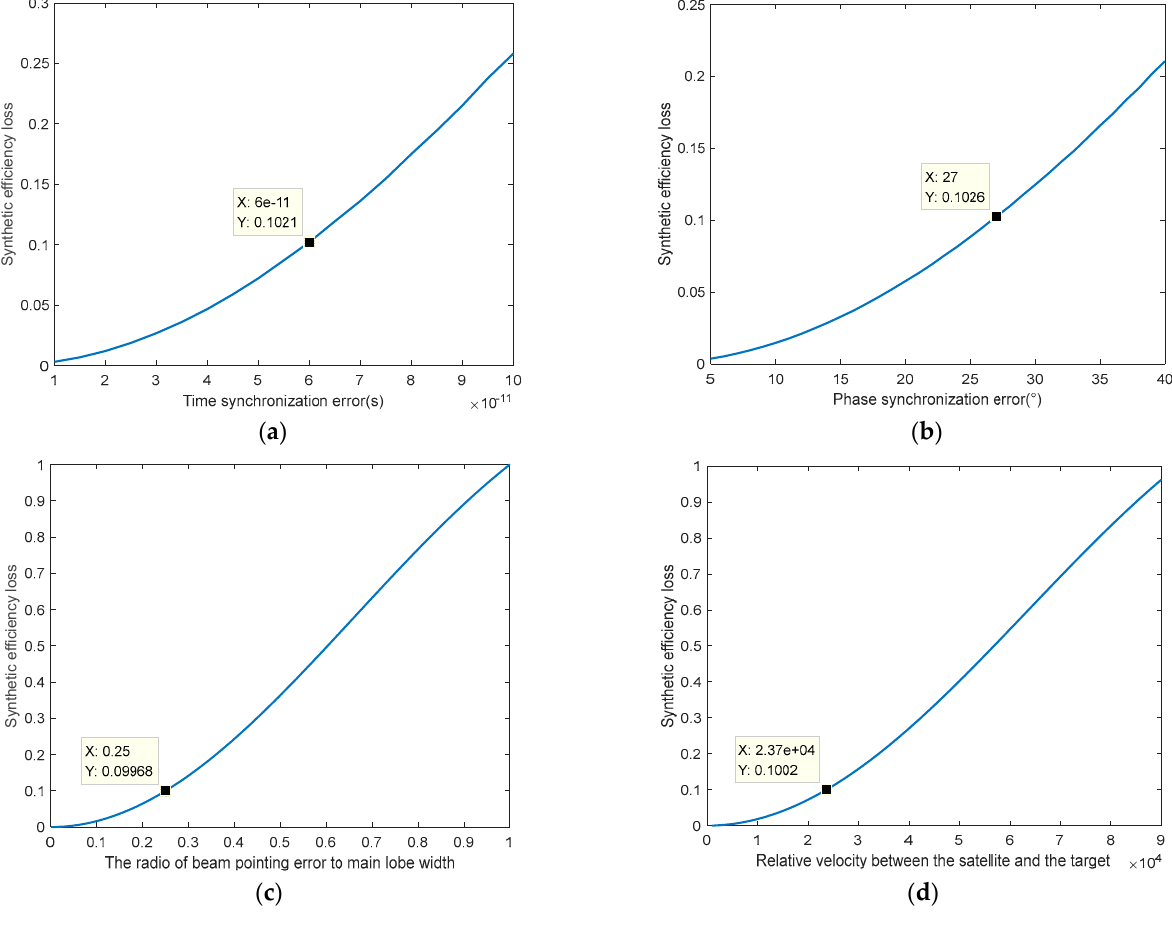
Figure 6. Integration efficiency with different non-ideal factors. ( a ) Influence of time synchronization error; ( b ) influence of phase synchronization error; ( c ) influence of beam pointing error; ( d ) influence of high-speed motion characteristics.